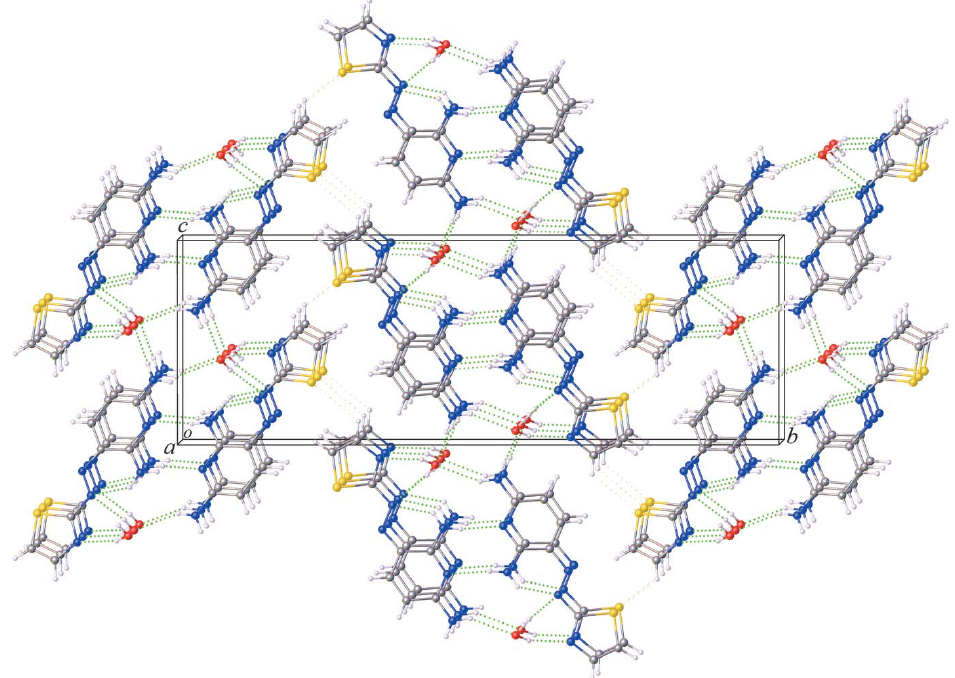
Figure 2 The unit-cell packing in (I) , viewed approximately down [100]. The classical O—H (cid:2)(cid:2)(cid:2) N, and N—H (cid:2)(cid:2)(cid:2) O hydrogen bonds are shown as green dashed lines (see Table 1 for numerical details).